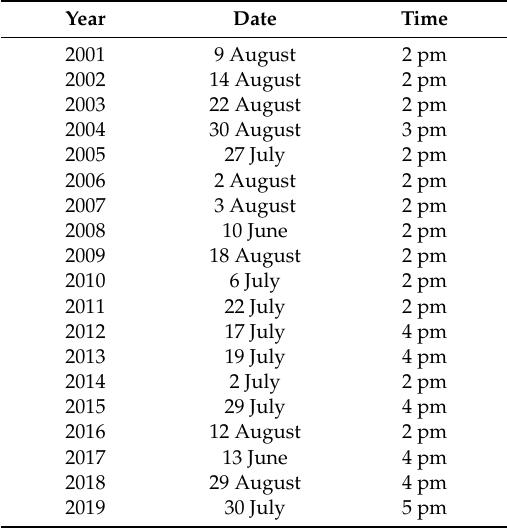
Table 2. ISO-NE historic ICAP tag